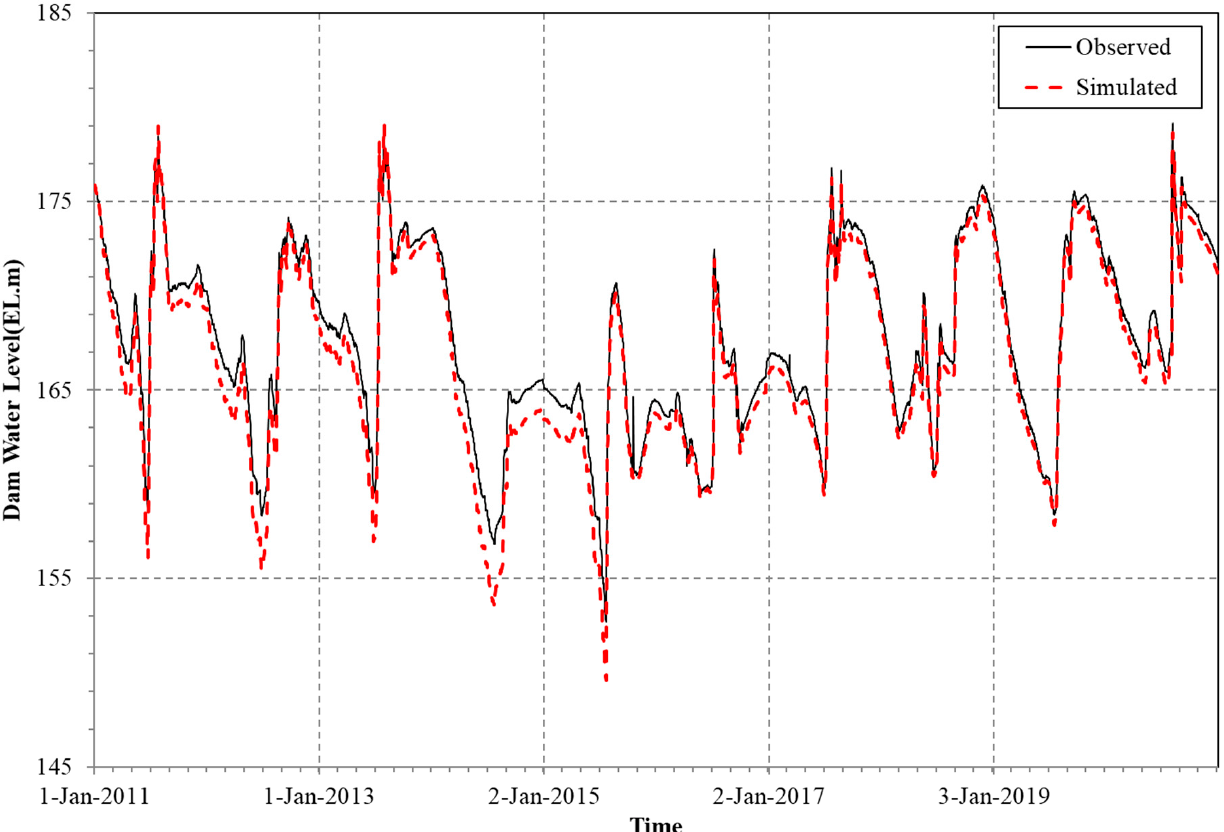
Figure 2. Evaluation results of HEC-5 (Hwacheon Dam).